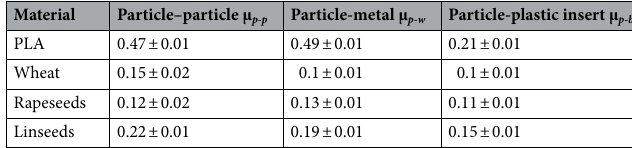
Table 2. Frictional parameters of PLA particles and seeds used for experiments.